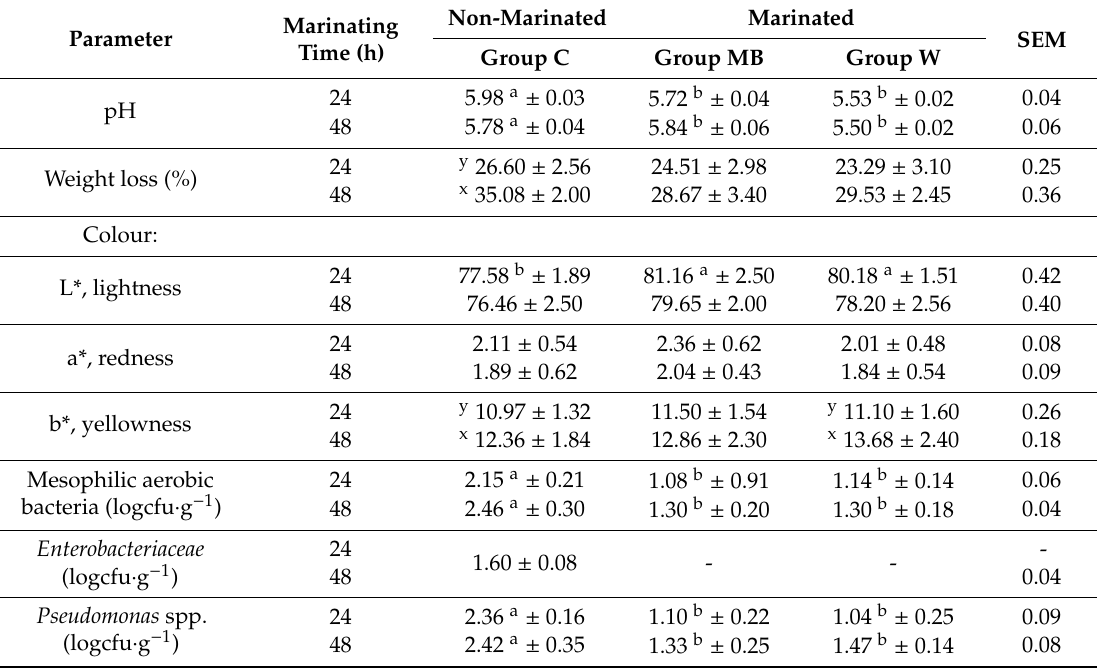
Table 2. E ff ect of marinating on physical and microbiological characteristics of roast